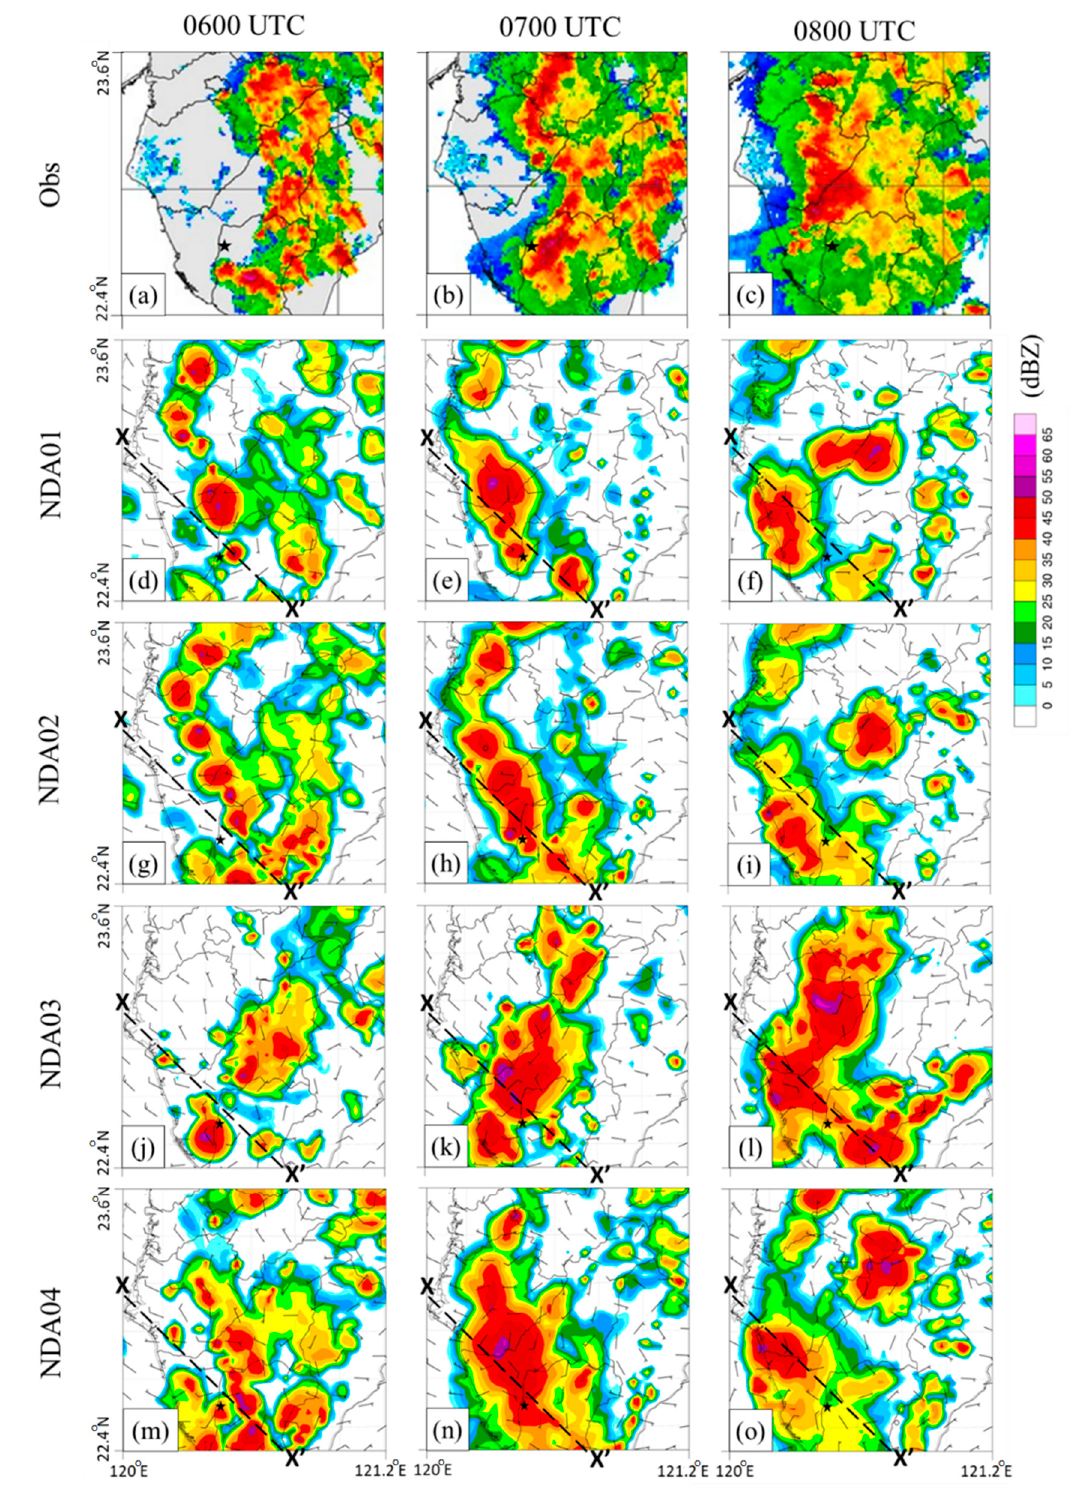
Figure 9. The observed and simulated 10-m wind (in arrow; intervals of 5 kt) and lowest model-level radar reflectivity (in color; dBZ) from 0600 to 0800 UTC (1400 to 1600 LST) on 5 August 2018, ( a – c ) observations, same as Figure 4, ( d – f ) NDA01, ( g – i ) NDA02, ( j – l ) NDA03, and ( m – o ) NDA04 simulations. Additionally shown are the approximate location of Pingtung Air Force Base (black star) and vertical cross-section planes (black line) for subsequent figures. The lines between x and x’ are plotted for further comparison of vertical distribution of convective cells near Pingtung Airport .